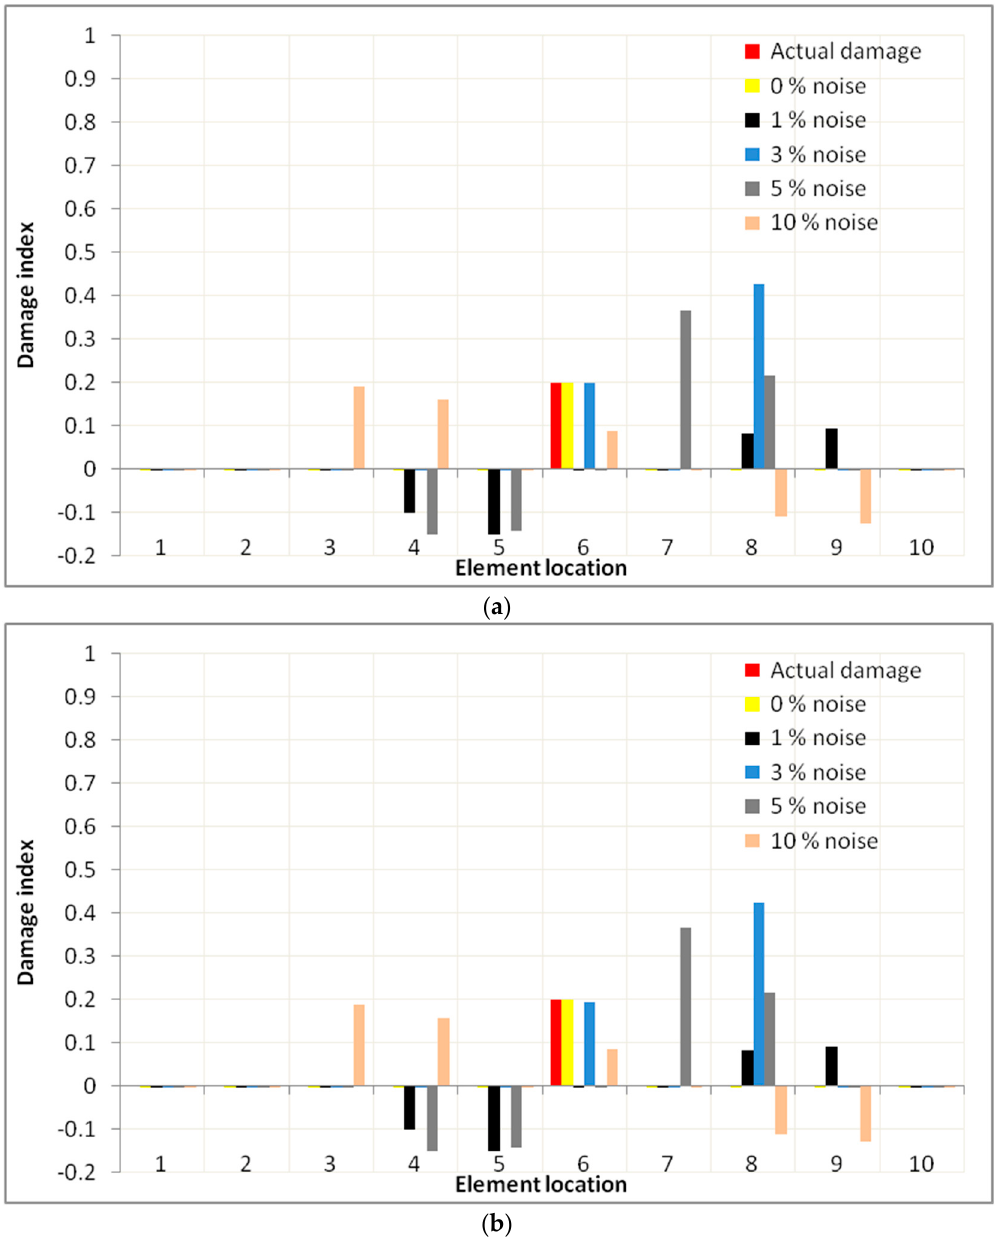
Figure 7. Damage distribution for Case 1 using Objective Function II with regularization for ( a ) noise both in frequency and mode shapes and ( b ) noise in mode shapes only.